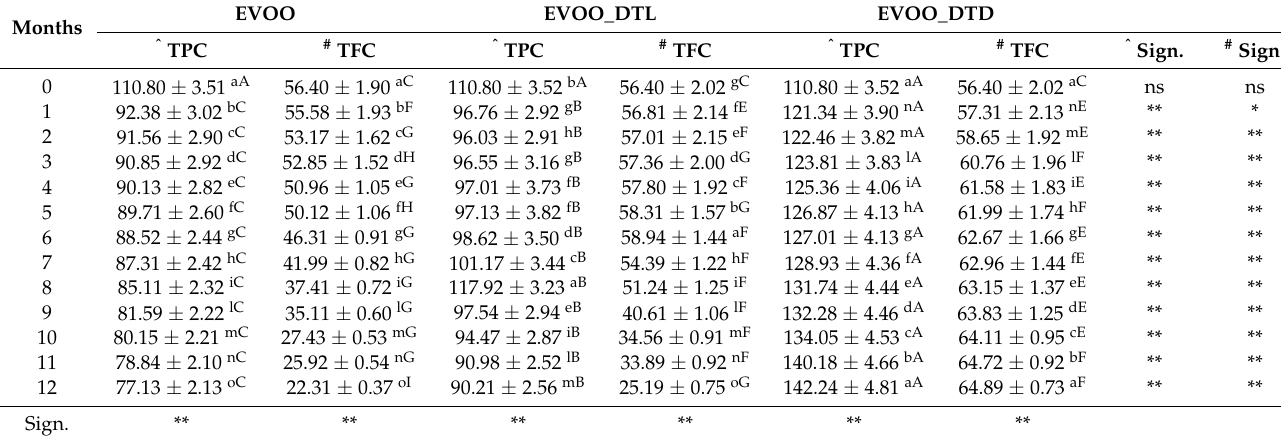
Table 6. TPC (mg CAE/g) and TFC (mg QE/g) content in EVOO, EVOO_DTD, and EVOO_DTL samples.